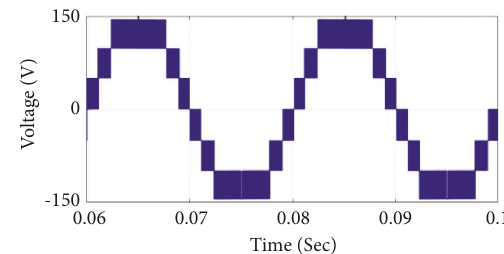
Figure 9: MLI output voltage (MI-0.5).